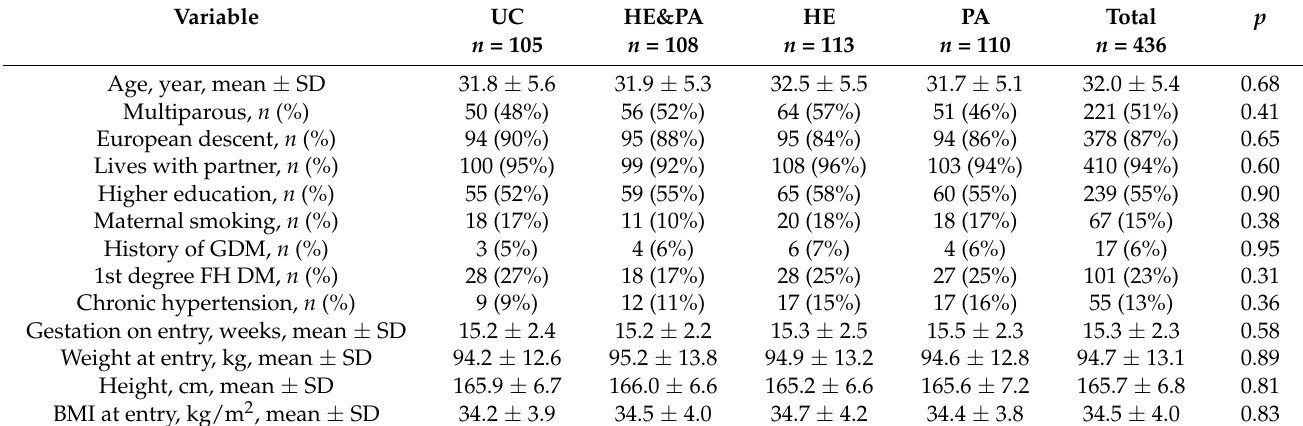
Table 1. Baseline characteristics of all women included per intervention